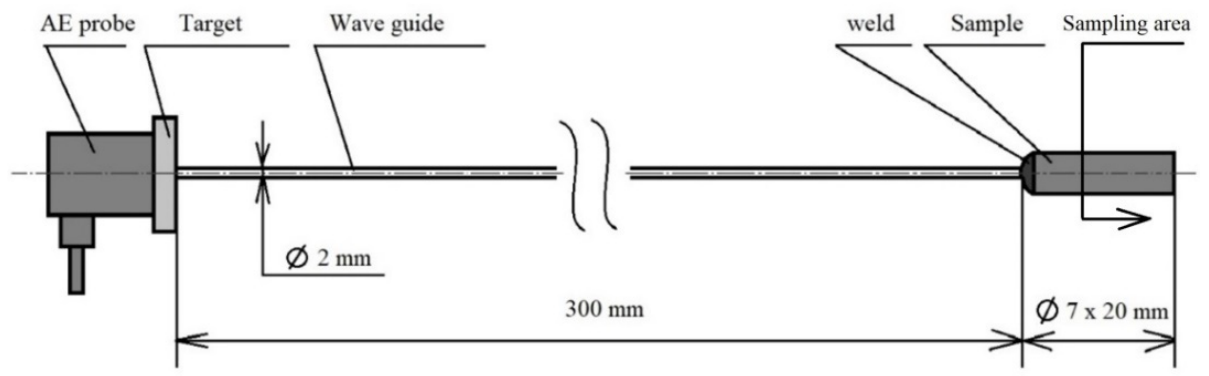
Figure 2. Test set-up.